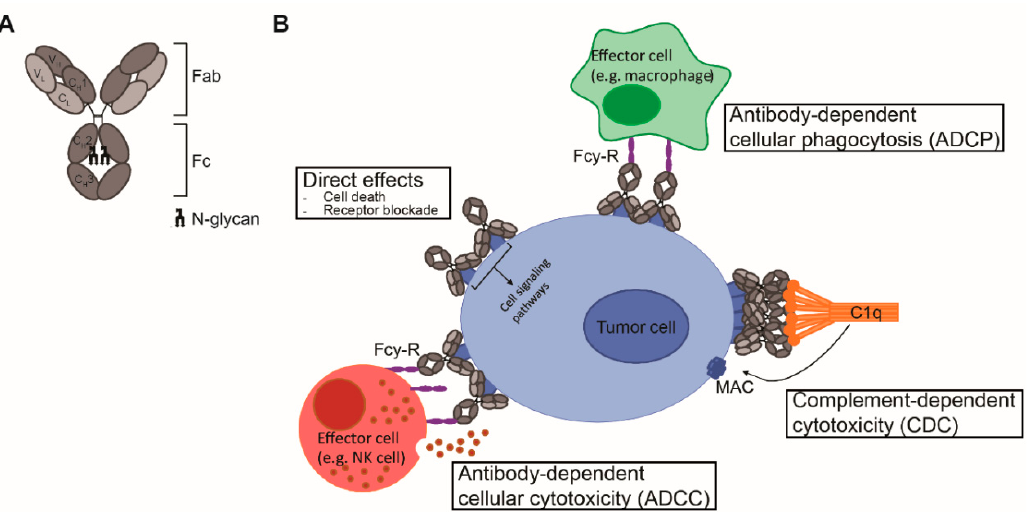
Figure 1. mAb structure and mechanisms of action. ( A ) Schematic representation of an IgG antibody consisting of variable (V) and constant (C) domains of the light (L; light grey) and heavy (H; dark grey) chains. The fragment antigen binding (Fab) domain is made up of V L and C L together with V H and C H 1, and the fragment crystallizable (Fc) region consists of C H 2 and C H 3, with an N-glycan attached to C H 2. ( B ) Mechanisms of action of IgG1 mAbs consist of direct e ff ects, including cell death and receptor blockade, and indirect e ff ects, including antibody-dependent cellular cytotoxicity (ADCC), antibody-dependent cellular phagocytosis (ADCP) and complement-dependent cytotoxicity (CDC). ADCC and ADCP are mediated via binding to Fc γ R and cell death occurs via release of cytotoxic granules and via internalization and degradation of the target, respectively. CDC is mediated via binding to complement protein C1q and cell death occurs via formation of the membrane attack complex (MAC), which consists of complement proteins C5b, C6, C7, and C8 and various copies of C9, and generates pores in the membrane.